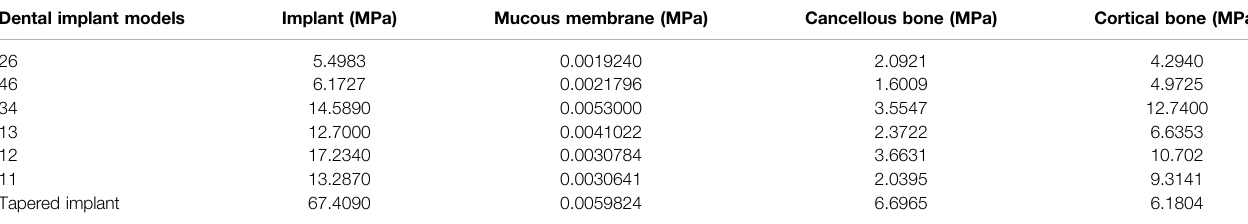
TABLE 2 | Maximum stress values when RAIs and tapered implant are subjected to 100-N vertical load. Dental implant models